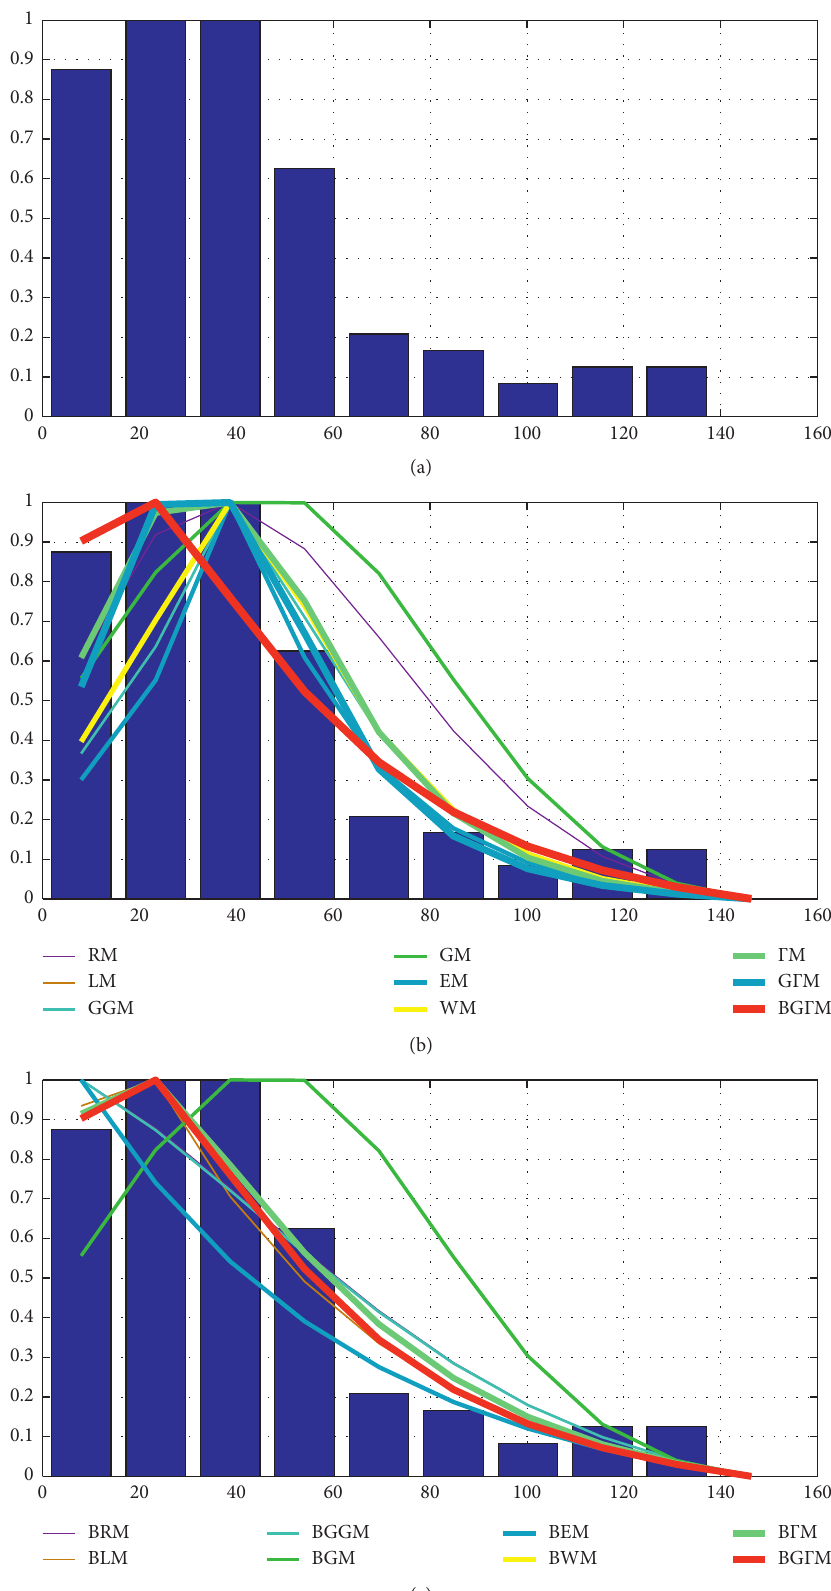
Figure 10: The estimated histogram. (a) The histogram of the survival times of 121 patients with breast cancer; (b) the estimated histogram of RM, LM, WM, GM, EM, GGM, Γ M, G Γ M, and G Γ M; (c) the estimated histogram of BRM, BLM, BWM, BGM, BEM, BGGM, B Γ M, and BG Γ